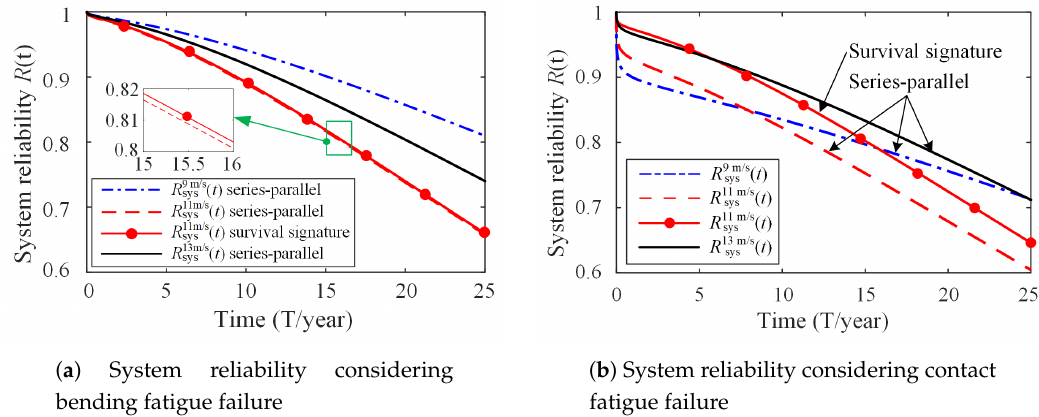
Figure 15. System reliability of wind turbine drivetrain considering different failure modes.